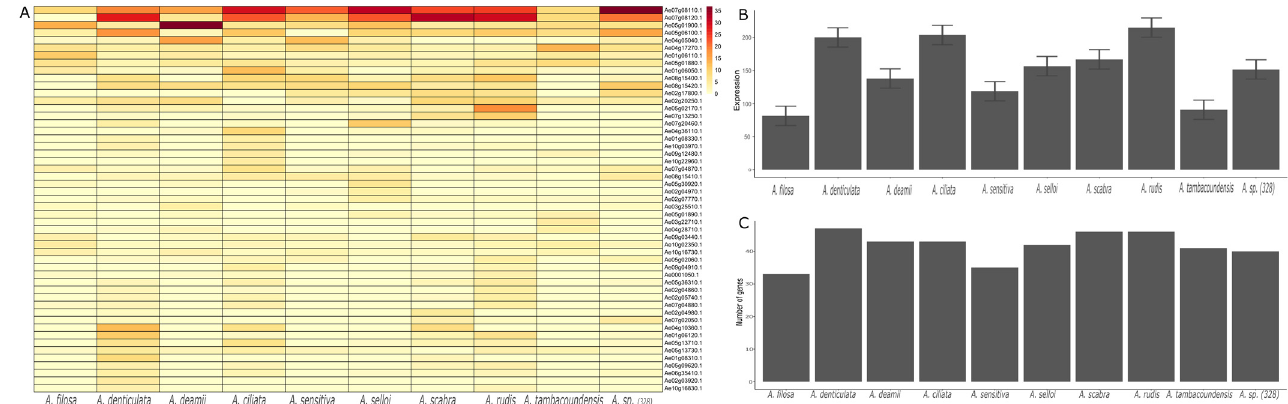
Figure 6. Expression of NLR genes in Aeschynomene species. ( A ) The heatmap plot represents the expression of 50 NLR genes across 10 species of Aeschynomene during the rooting stage (day 7). ( B ) The bar plots show the variable cumulative gene expression of NLR in different species under the stress condition of drought. ( C ) The bar plot represents the number of genes expressed during this stage in different species.